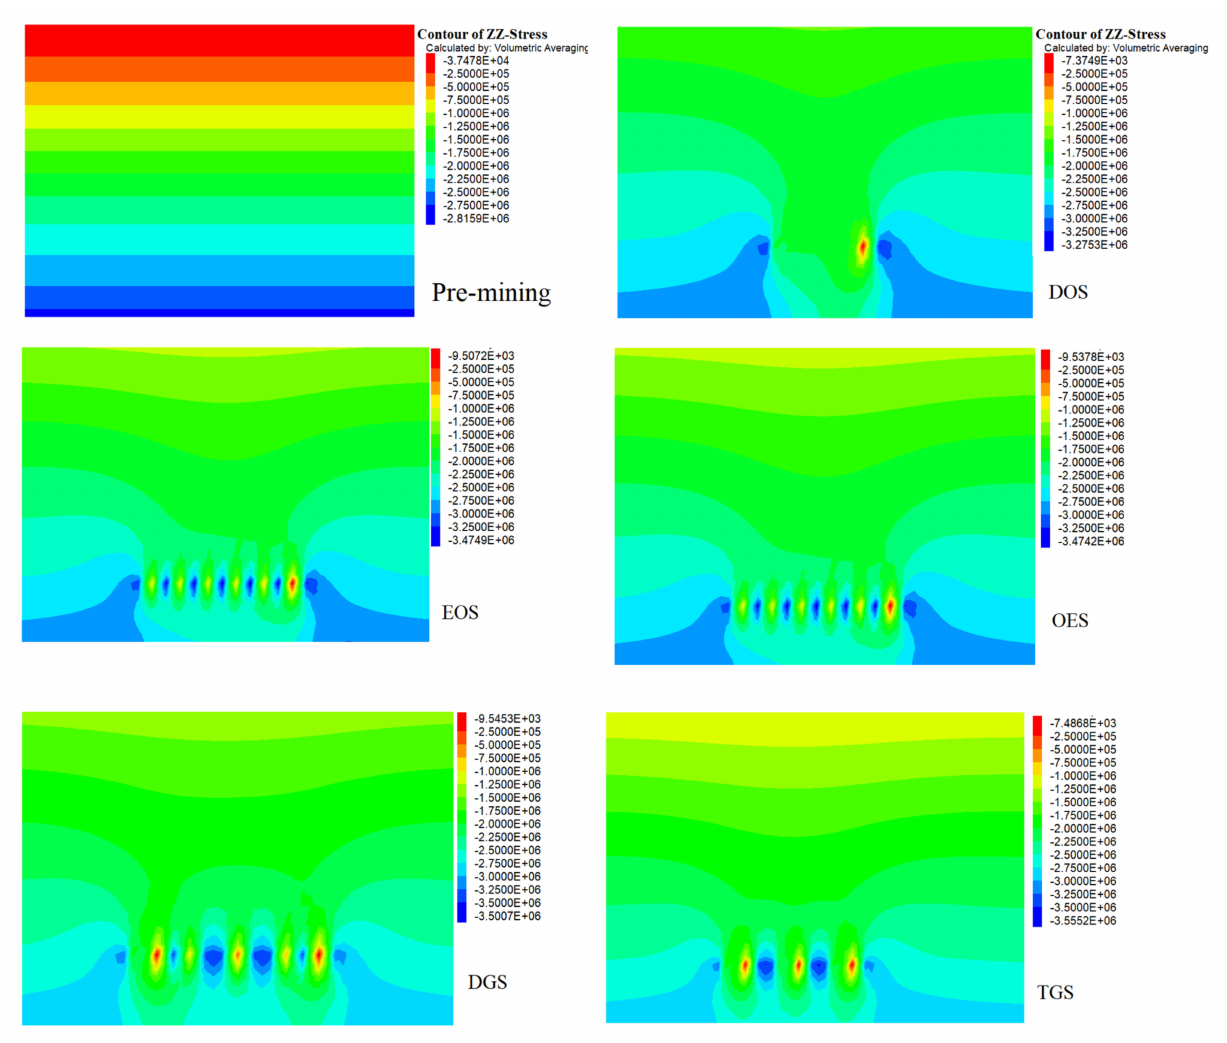
Figure 8. Contours of vertical stresses across five